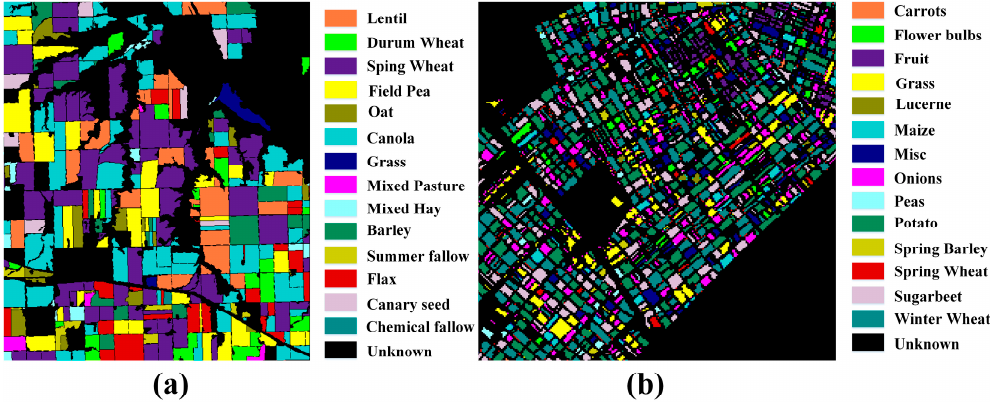
Figure 7. Ground truth maps of the experimental sites: ( a ) Indian Head and ( b ) 1